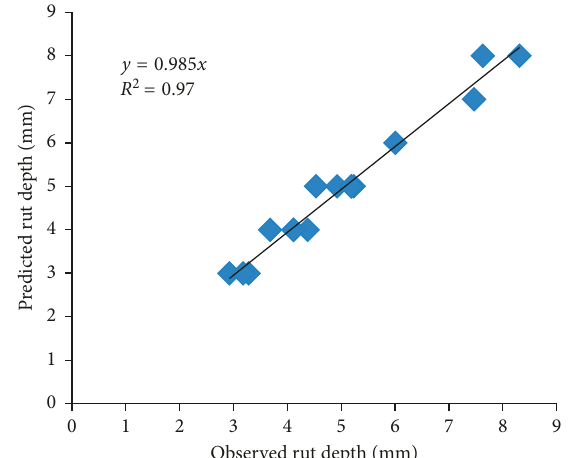
Figure 17: Scatter plot between observed versus predicted rutting for training.